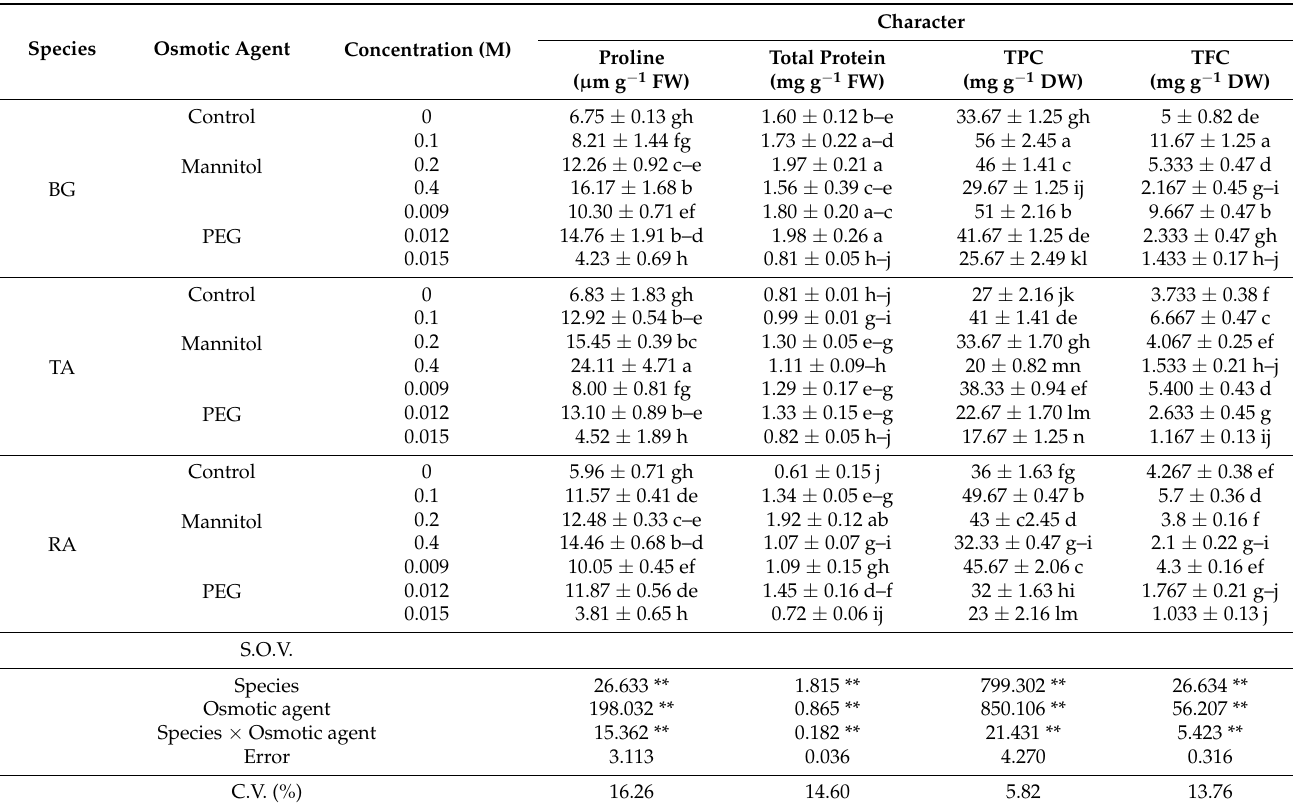
Table 3. Effect of osmotic stress induced by mannitol and PEG on proline, total protein, TPC, and TFC traits of Cucurbita sp. under in vitro condition.